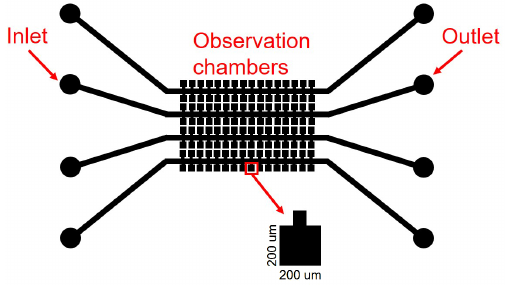
FIG. 6. Schematic diagram of our independent four-channel microfluidic chip. The image shows the structure of the channel, which consists of the main sulcus and the lower chambers on both sides. These chambers are designed for cell observation. Some of the cells are forced into the chamber after the bacteria is injected through the inlet. The culture is then passed through the inlet to ensure that the cells can grow normally. All specific parameters of our chip are shown in Appendix A